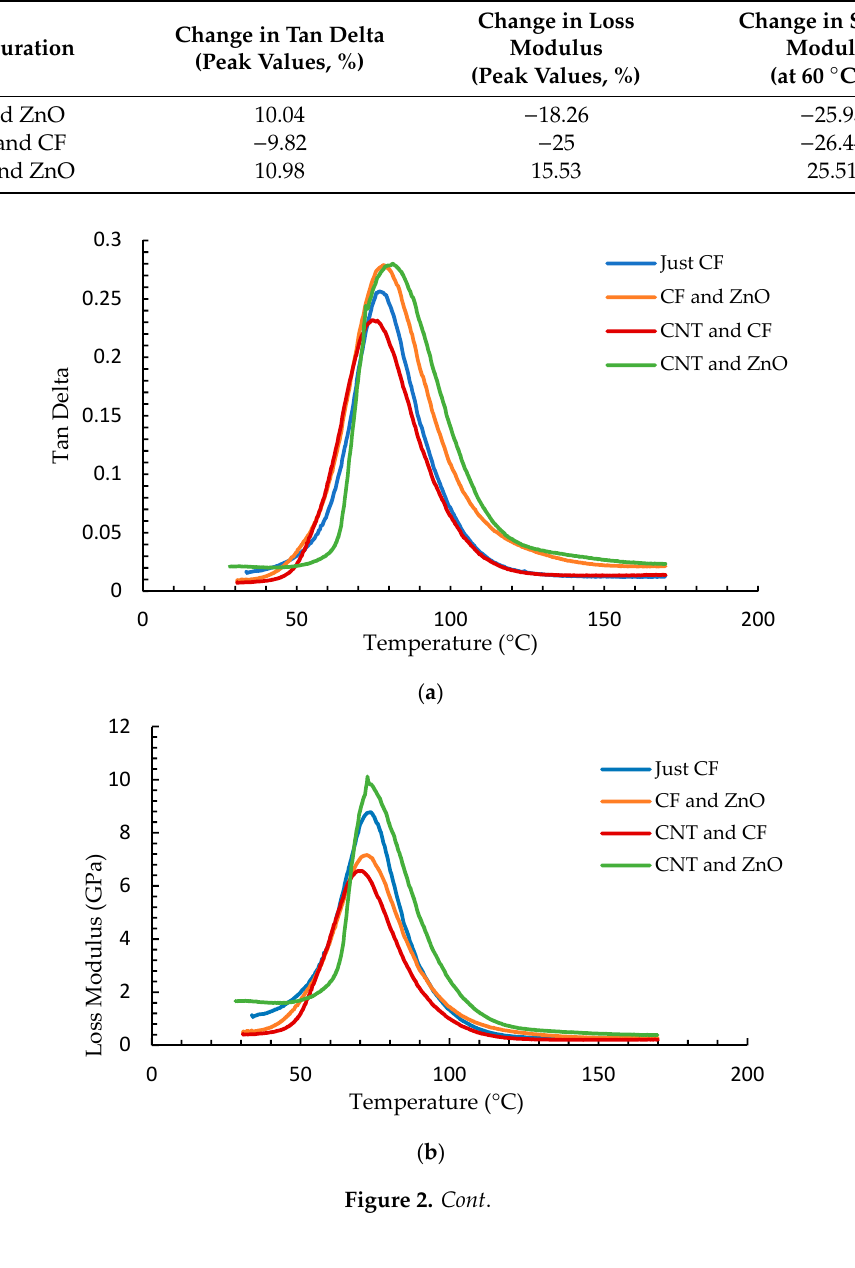
Table 2. Comparison of the performance of the various composites’ configurations with respect to the composite based on CF under temperature sweep.